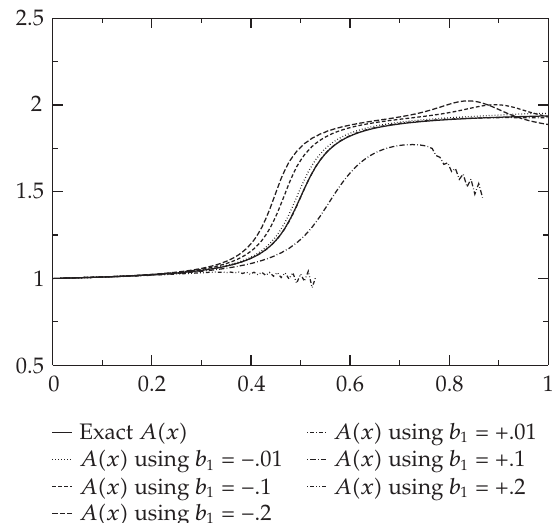
Figure 7.2 . The reconstructed cross-sectional area A ( x ) = 1 + arctan ( 10 ) /π + arctan ( 20 ( x − . 5 )) /π for various b 1 values using n = 128 grid